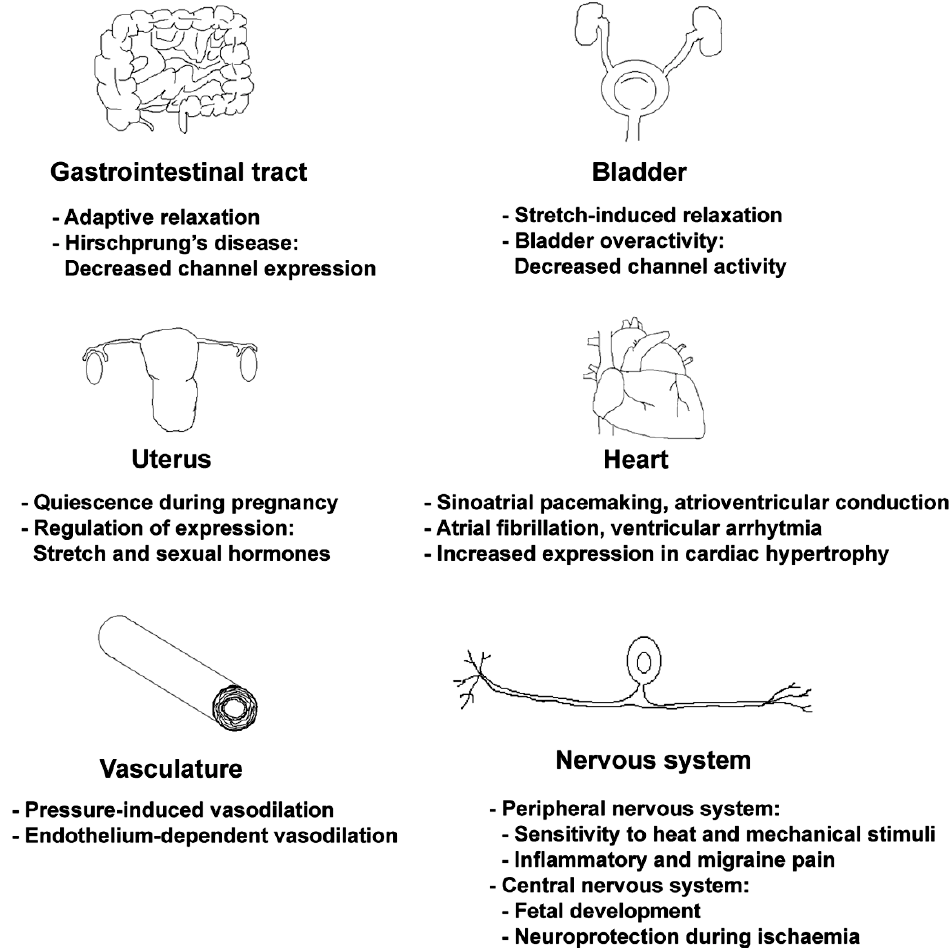
Figure 5. A summary of the physiological and pathophysiological roles of mechanosensitive K 2P channels in different organs. For further details, see the corresponding text.